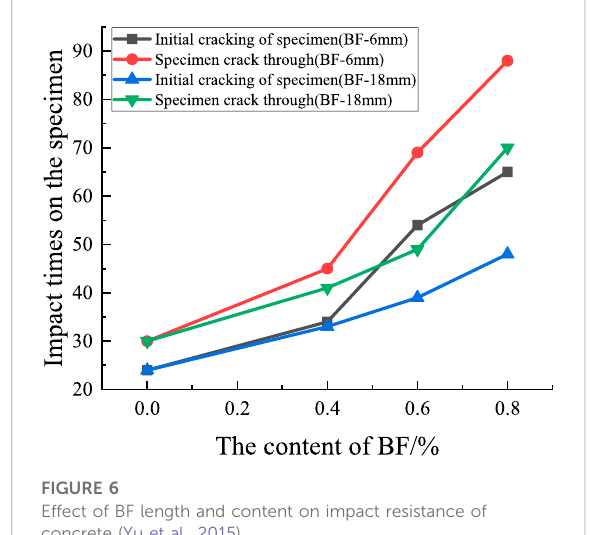
FIGURE 6 Effect of BF length and content on impact resistance of concrete (Yu et al.,